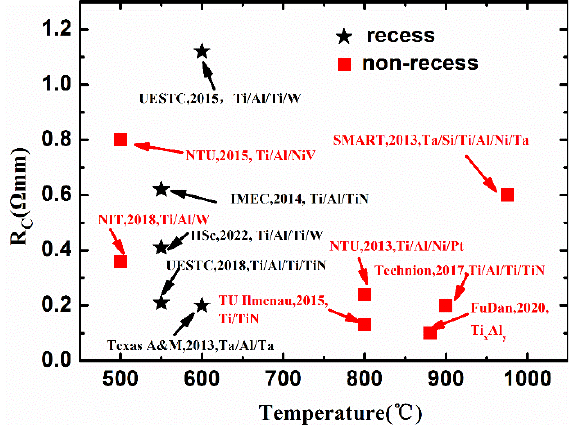
Figure 10. Comparison of R C as a function of annealing temperature of different Au-free ohmic contact to AlGaN/GaN HEMT from various publications.